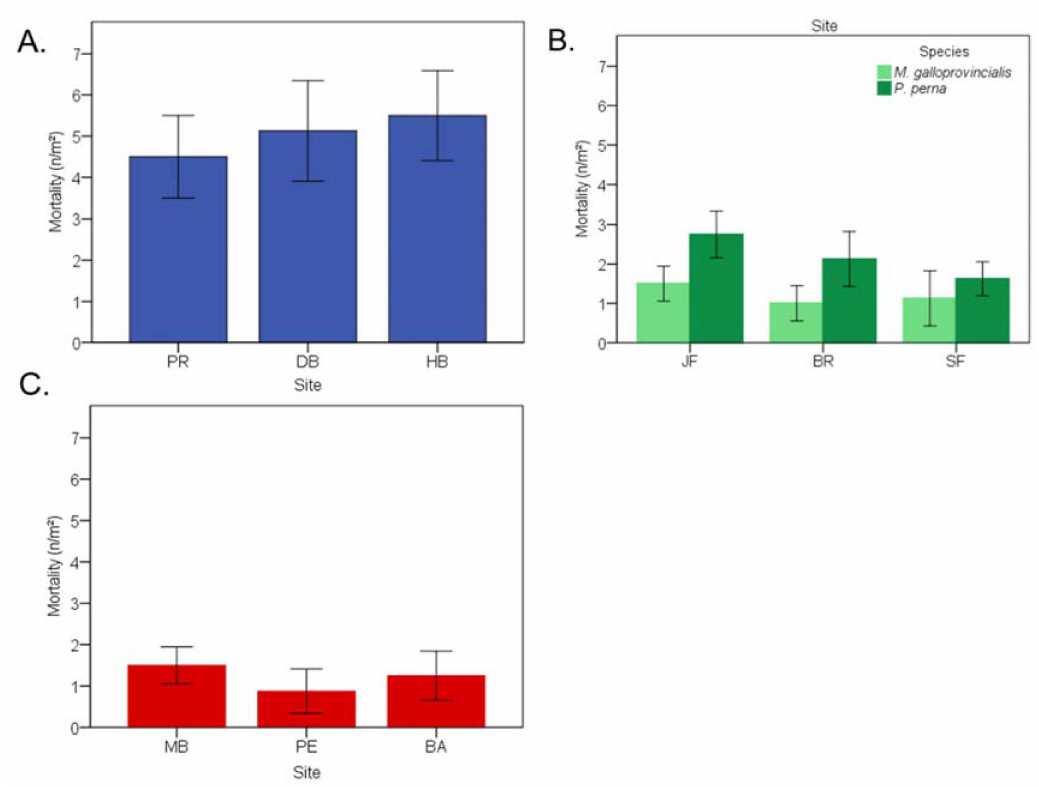
Figure 7. Mean endolithic induced mortality ( ± 95% CI) within the three coastal bioregions of South Africa ( A ) Cool Temperate, ( B ) Warm Temperate, ( C ) Subtropical bioregion. In the warm temperate bioregion, where both species coexist, two bars are plotted for each site, one for each mussel species. In the subtropical bioregion, P. perna had an average mortality of 1.5 dead mussels / m 2 , with an average of 2.1 in the warm temperate bioregion (Figure 7B,C). For this species, endolith induced mortality rates did not di ff er between the two bioregions (ANOVA: F 1,42 = 6.612; p = 0.062). In the warm temperate bioregion, mortality rates for P. perna were significantly higher at JF than at SF ( p < 0.05). In the warm temperate bioregion, P. perna su ff ered higher rates of mortality than M. galloprovincialis , but the di ff erence was marginally non-significant (species: p = 0.054; Figure